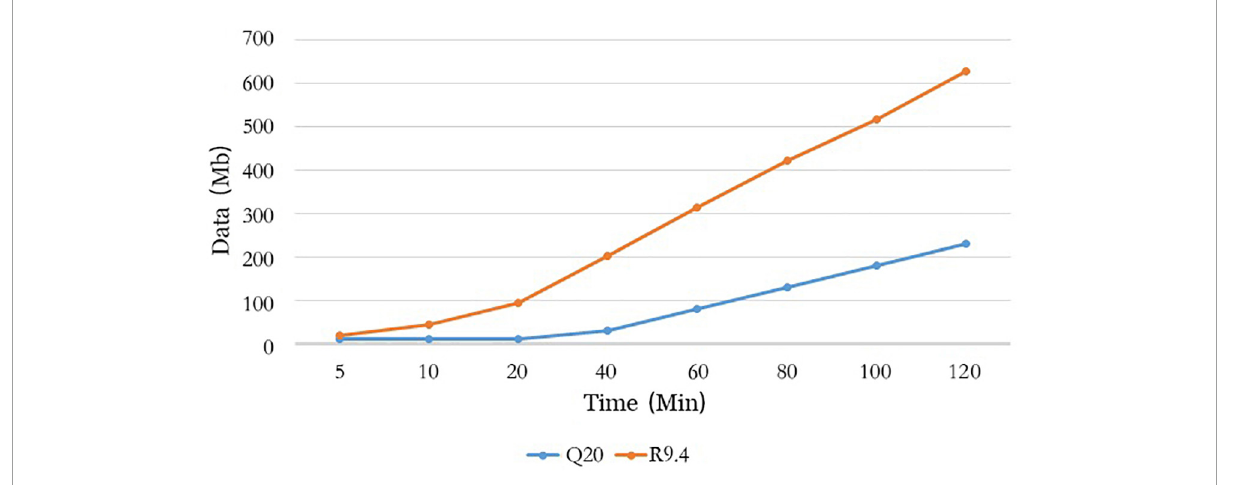
FIGURE5 Comparison of method A with method B for data output over